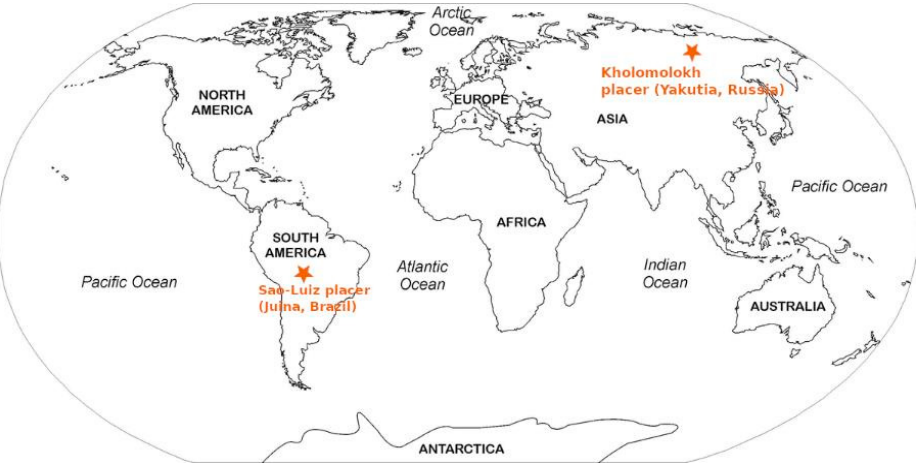
Figure 1. Location map of studied super-deep diamonds.